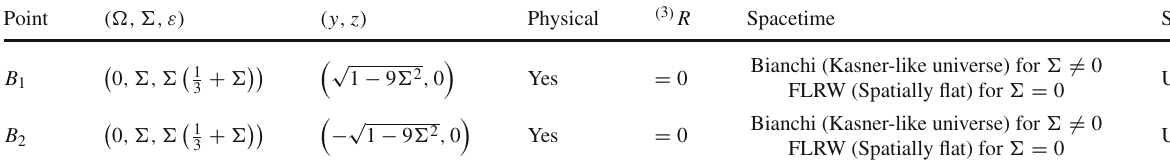
Table 2 Critical points of family (B)